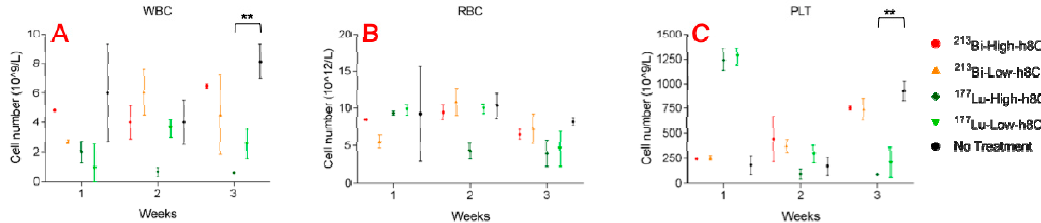
Figure 4. Blood chemistry (white blood cells, red blood cells and platelet) of B16-F10 melanoma- bearing mice treated with 177 Lu-h8C3 and 213 Bi-h8C3. A,B,C—WBC, RBC and PLT, respectively. Low dose—7.4 MBq; high dose—14.8 MBq. ** indicate statistical significance P =